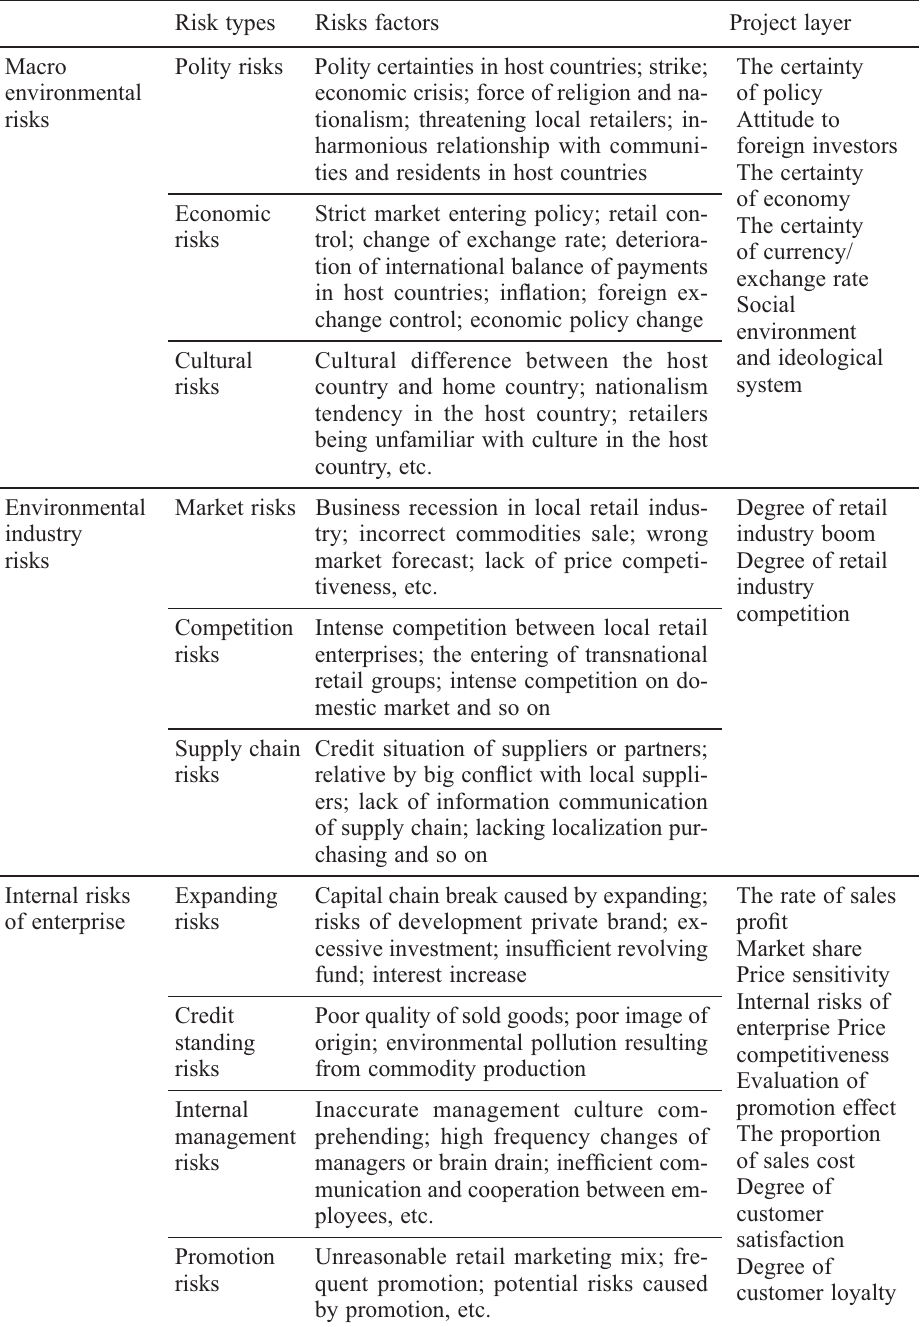
Table 1. Environmental risk types and factors infl uencing their occurrence in retail enterprise transnational marketing (Zhang et al .